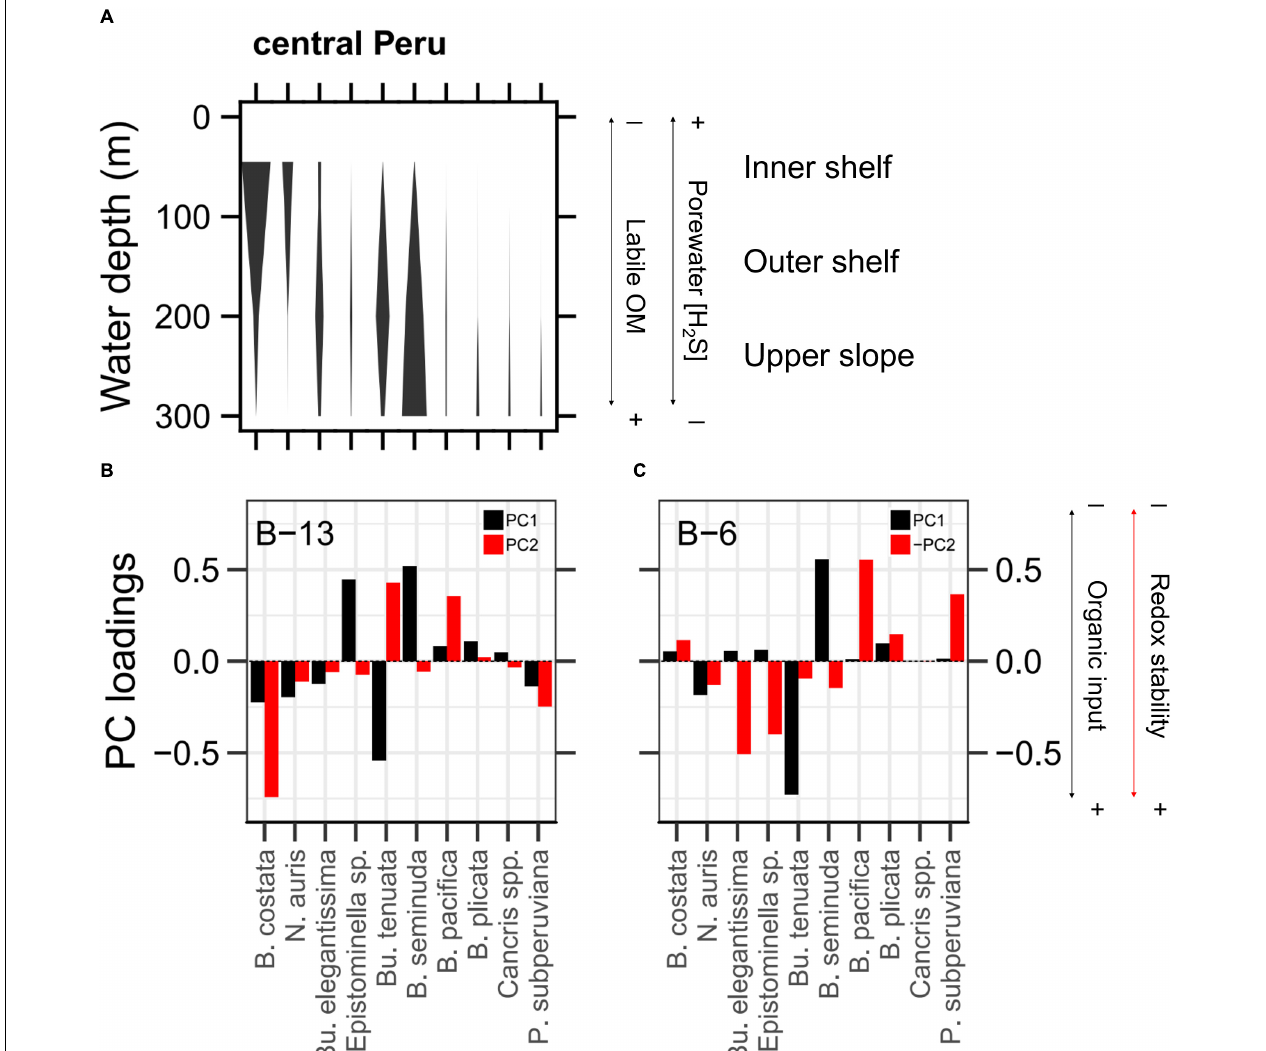
FIGURE 4 | Interpretation of benthic foraminiferal assemblages. (A) Distribution of living species in central Peru from several databases: Callao and Pisco upper margin for the 2009 – 2011 period (Cardich et al., 2015) and for the 2012 – 2017 period (Benthos Lab of IMARPE); Callao and Huacho upper margin (M77-2 cruise, 2008; Mallon et al., 2012); Callao upper slope (Panorama Leg3a cruise, 1997; Pérez et al., 2002) and (M92-2 cruise, 2013; Cardich et al., un published). Width of bars indicate mean relative abundance for each species. (B,C) Loadings of principal component 1 (black bars) and principal component 2 (red bars) for B-13 (Callao) and B-6 (Pisco). Opposite values of B-6’s PC2 scores are shown to maintain coherence in the